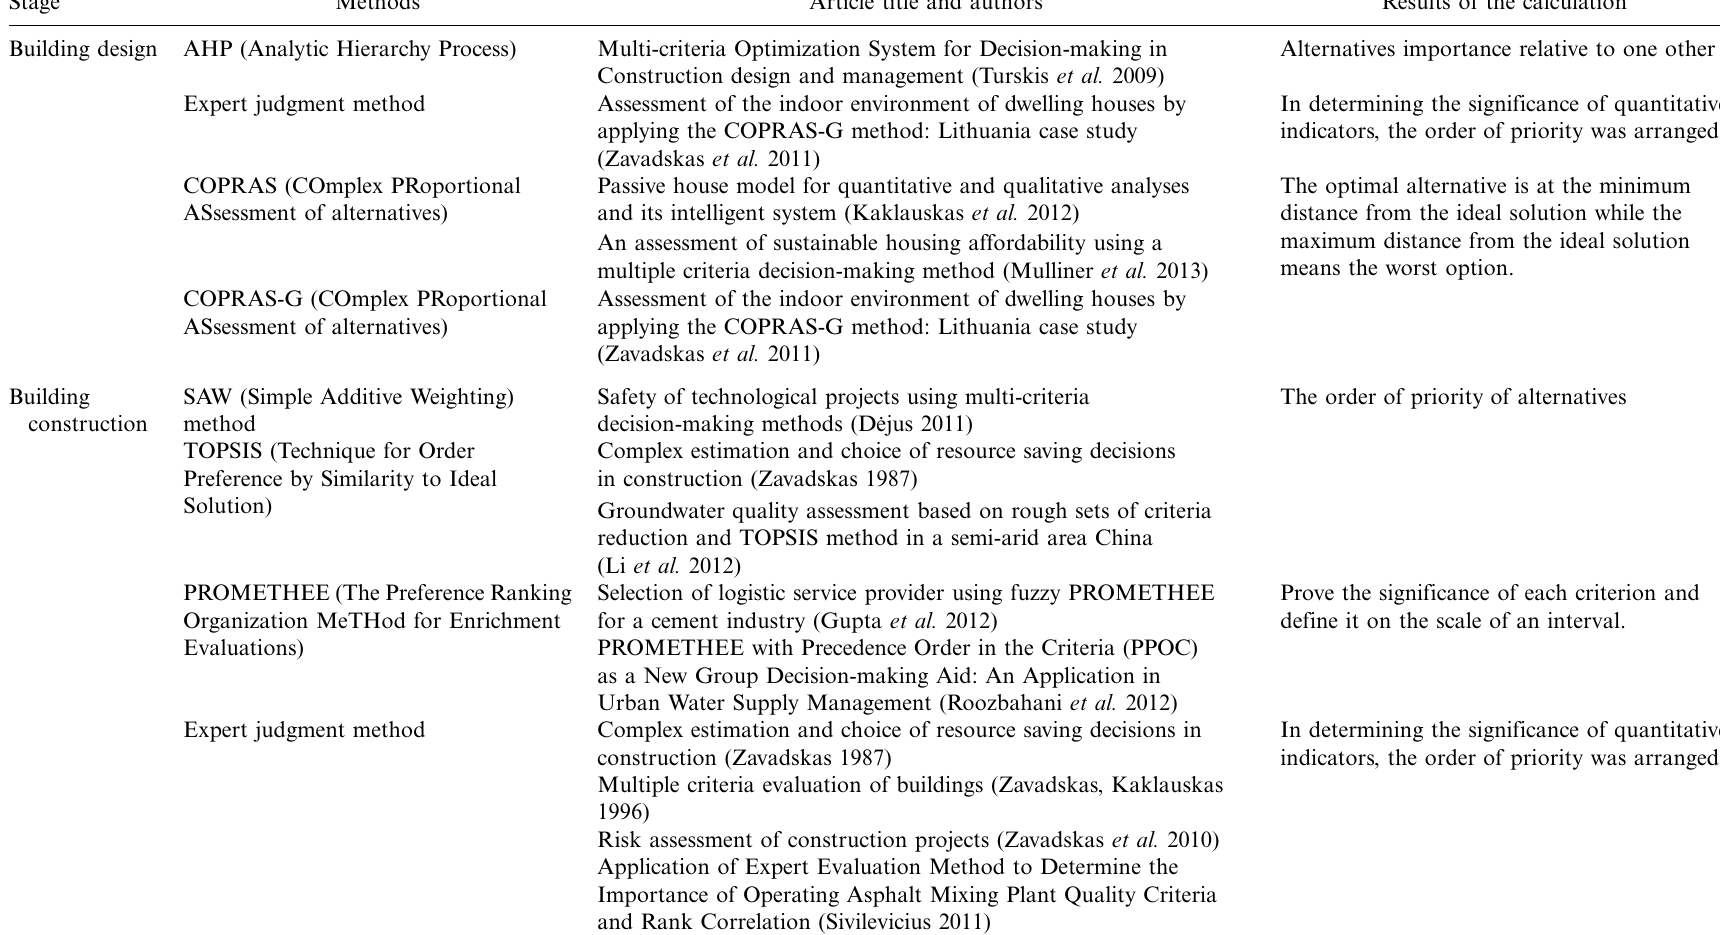
Table 1. Use of MCDM in the analysis of a building life cycle